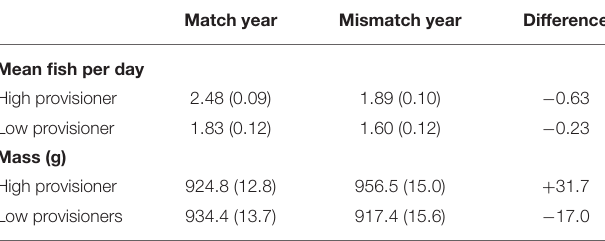
TABLE 5 | Low-provisioning common murres decreased their mean ( ± SE) daily provisioning rate less and lost more body mass than their high provisioning mates in the predator-prey mismatch year (2000) compared to the match year